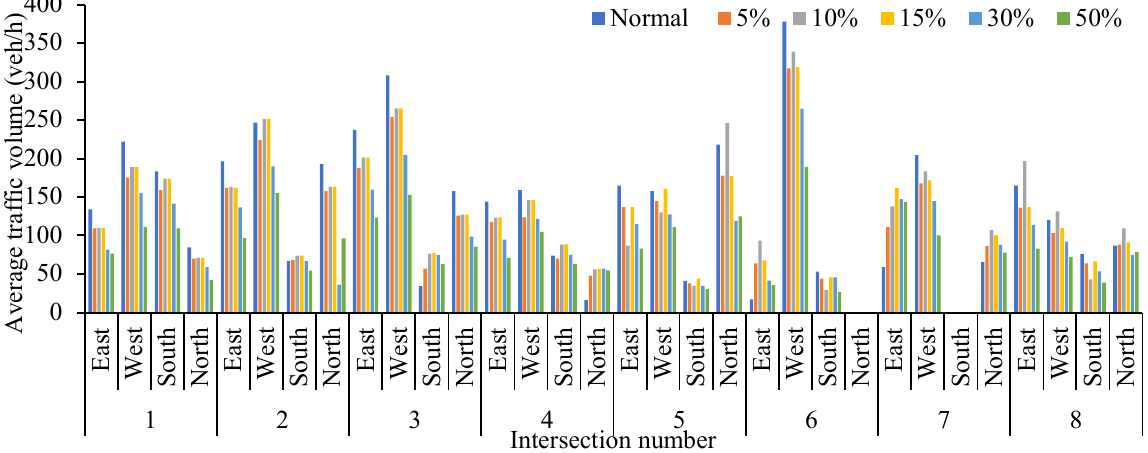
Figure 6. Comparison of average traffic volumes at different intersections.